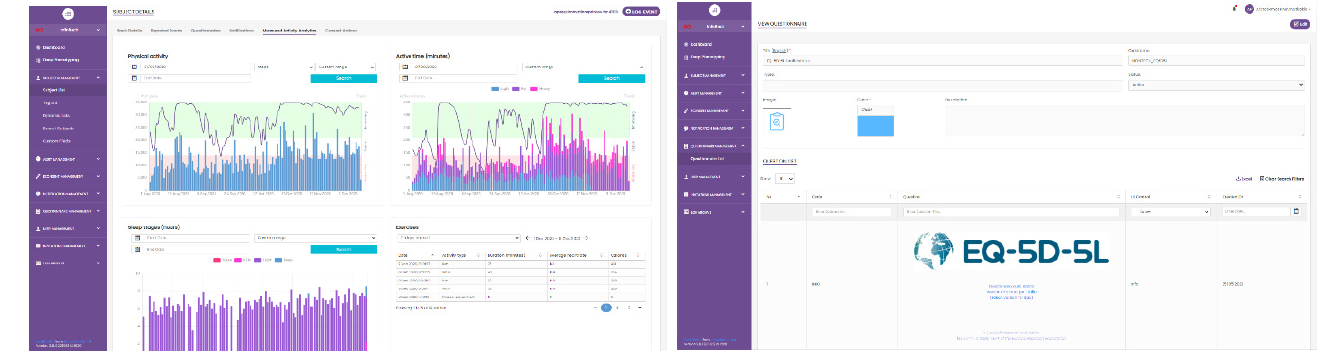
Figure 2. Healthentia portal application—viewing measurements and creating questionnaires.